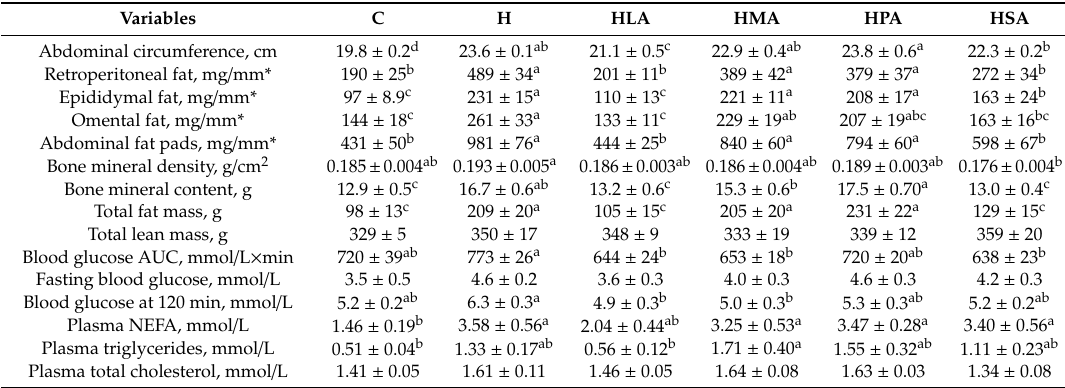
Table 2. Metabolic parameters in rats treated with fatty